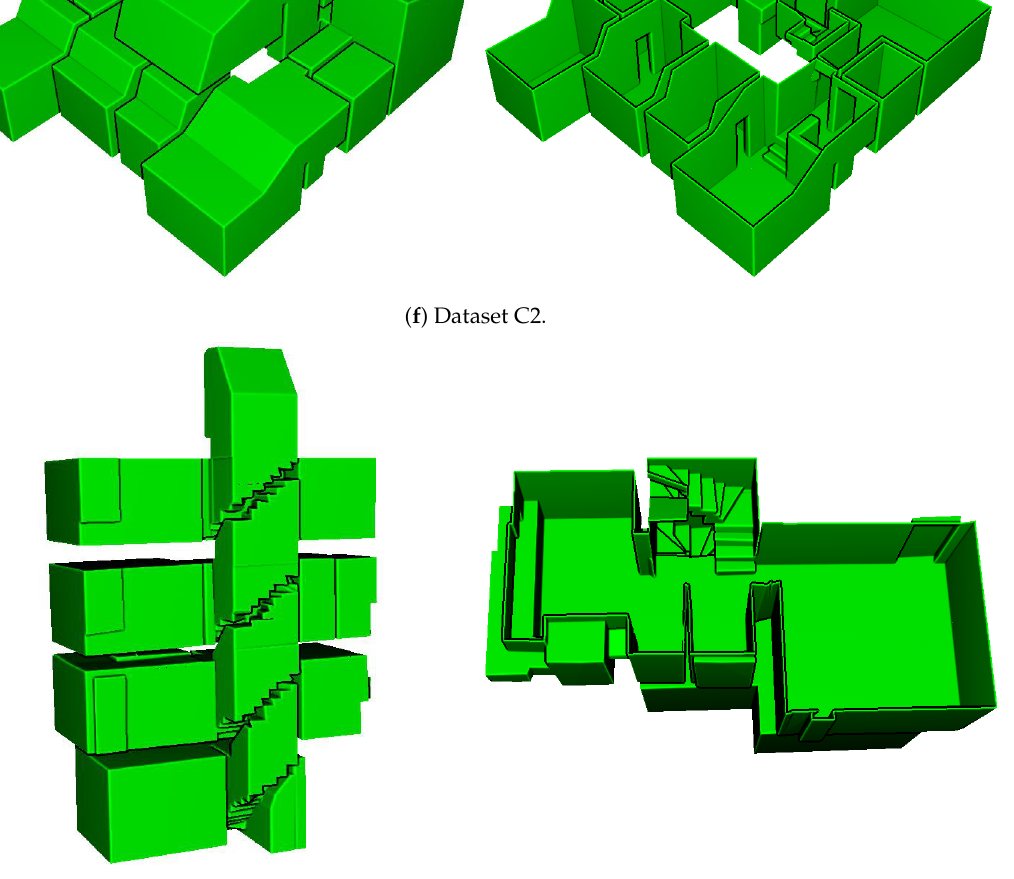
Figure 10. Results of the generated water-tight meshes. The bird’s-eye view of the entire spaces (left) and the fist floor without ceilings (right) are